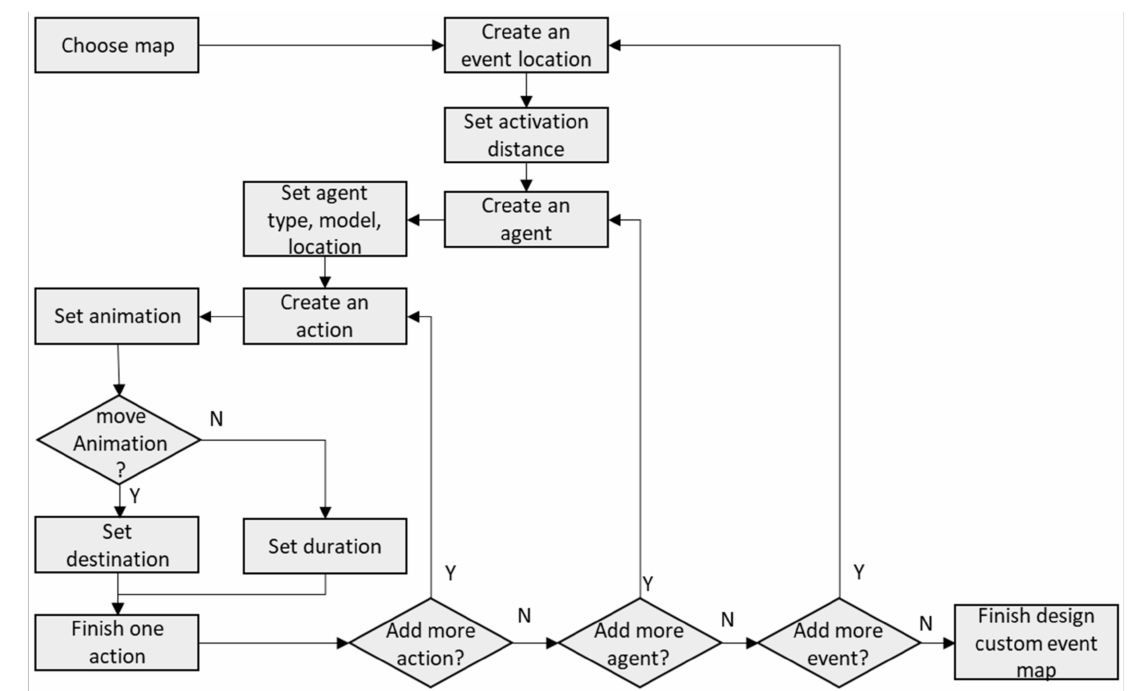
Figure 6. Configuration process of the custom event mode.